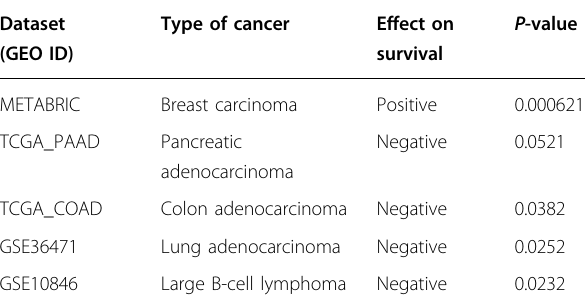
Table 2 The expression level of SEMG2 is negatively associated with survival rate of cancer patients.